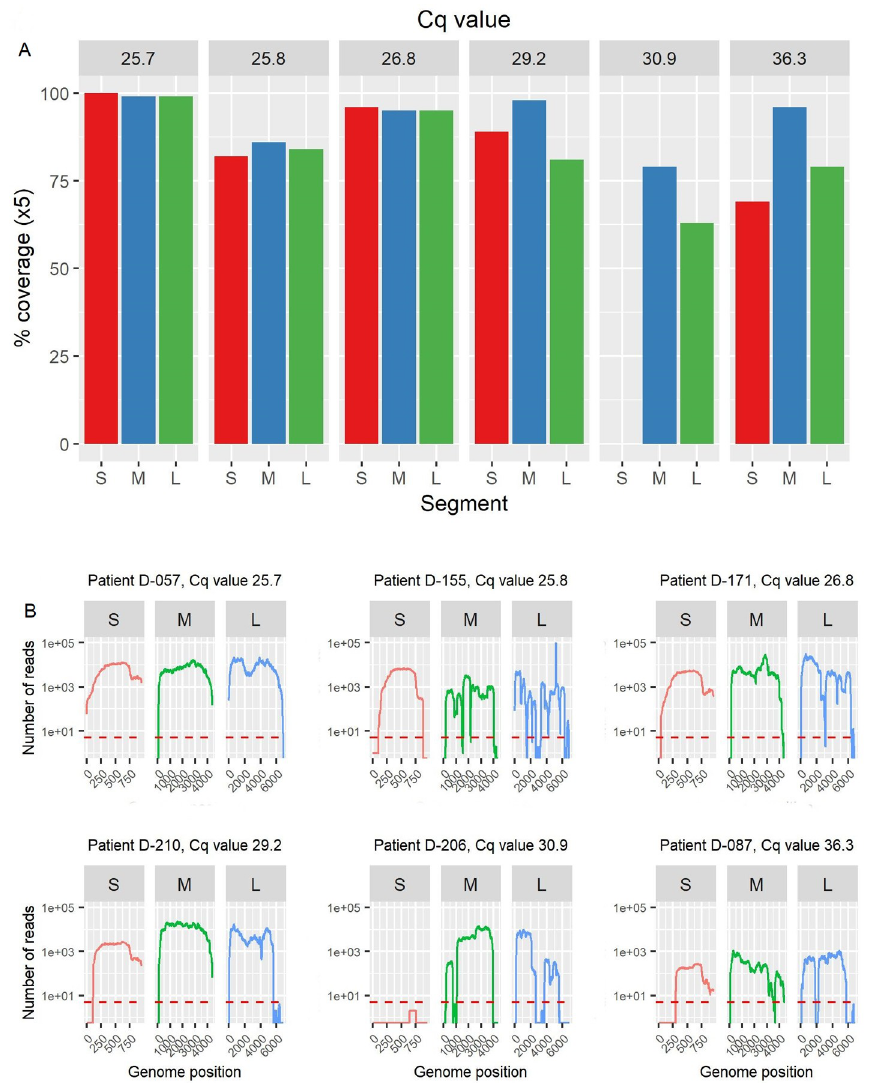
Fig 3. OROV genome coverage generated from six OROV-positive patient plasma samples, using a metagenomic sequencing approach. Reads were mapped to reference sequences OROV/EC/Esmeraldas/087/2016 (GenBank accessions MF926352.1- MF926354.1). Panel A: OROV genome segment (S, M, L) coverage (%). qRT-PCR Cq value is given at the top of each plot. Coverage is defined as a minimum of 5 reads at any given position. Panel B: OROV genome coverage shown as the number of reads at each genomic position. Plots are separated by genome segment (S, M, L). Red dashed line indicates 5x coverage.